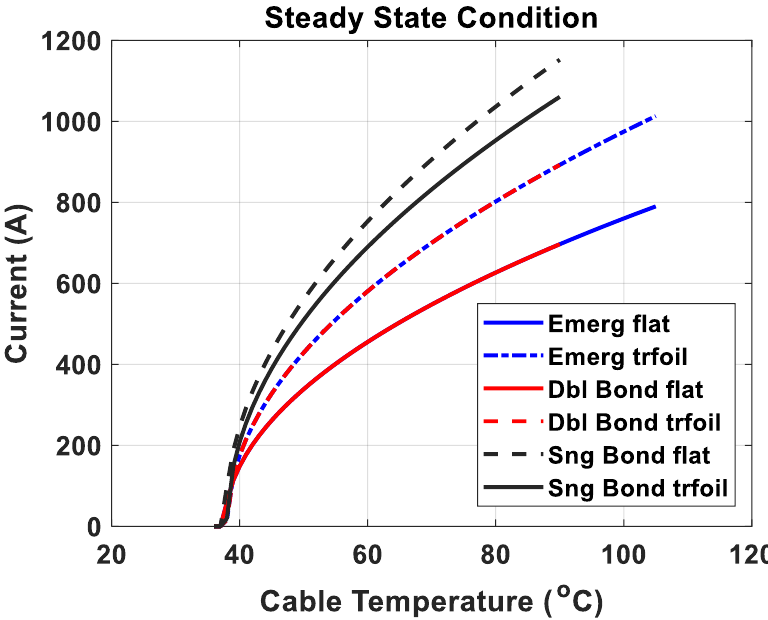
Figure 11. Effect of the bond category on the cable ampacity with the variation of cable tempera- ture.